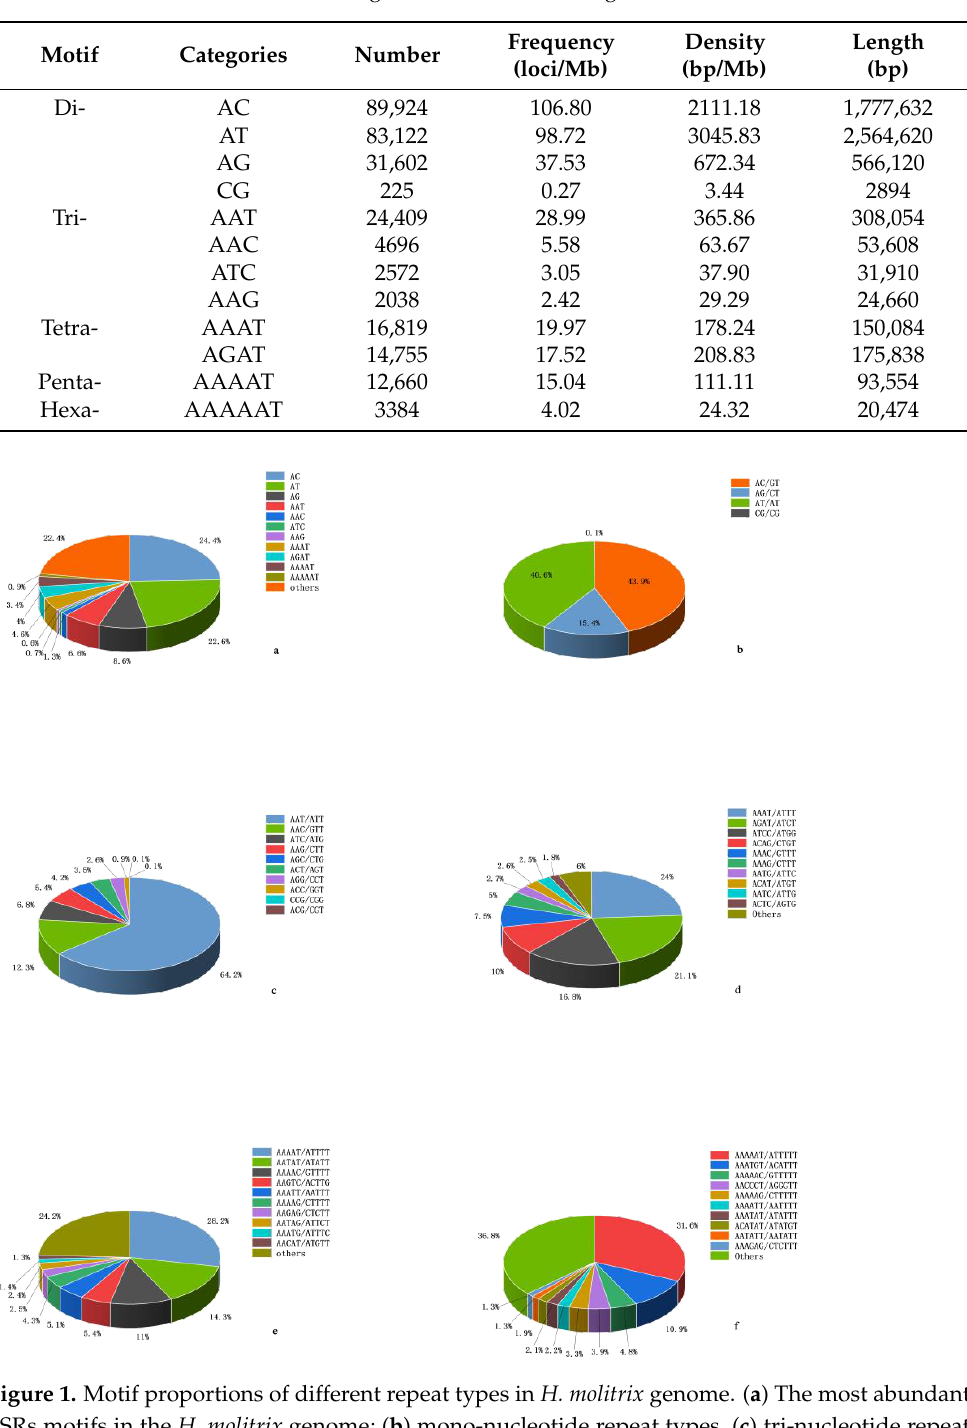
Figure 1. Motif proportions of different repeat types in H. molitrix genome. ( a ) The most abundant repeat SSRs motifs in the H. molitrix genome; ( b ) mono-nucleotide repeat types, ( c ) tri-nucleotide repeat types, ( d ) tera-nucleotide repeat types, ( e ) penta-nucleotide repeat types, and ( f ) hexa-nucleotide repeat types.